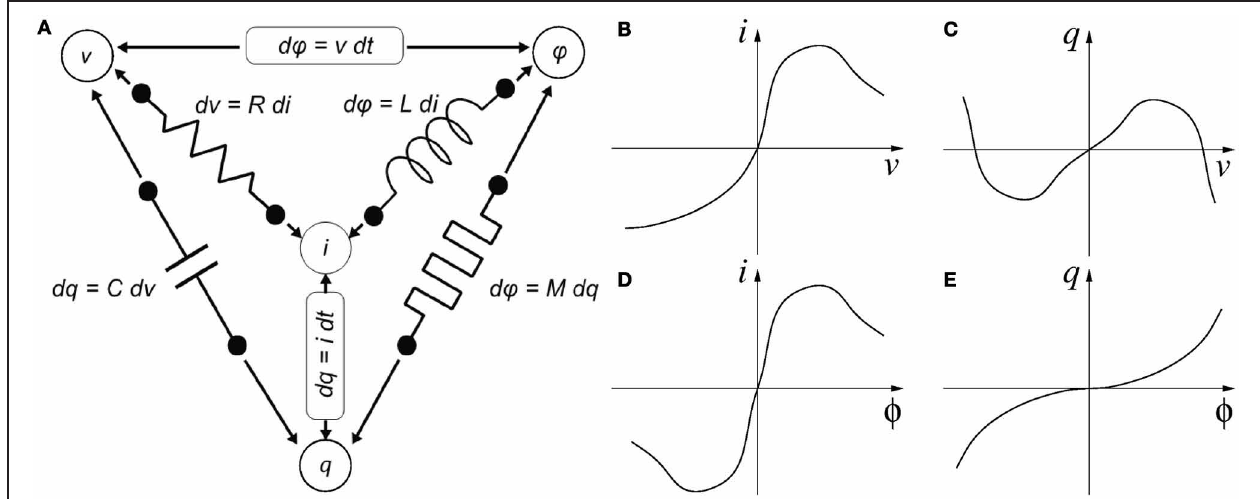
FIGURE 1 | Four variables of circuit theory linked by six mathematical relations consisting of the functional relationships of the four passive circuit elements, Faradays law of induction and the definition of electric current. (A) Chua’s symmetry argument and (B–E) descriptions of the four canonical two-terminal devices. (B) A resistor is defined by a static